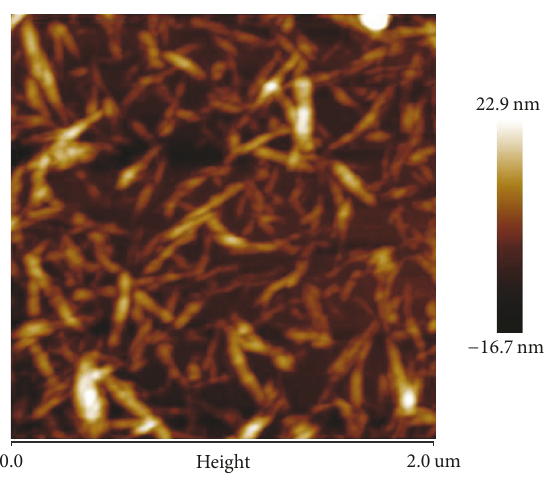
Figure 1: The AFM image of